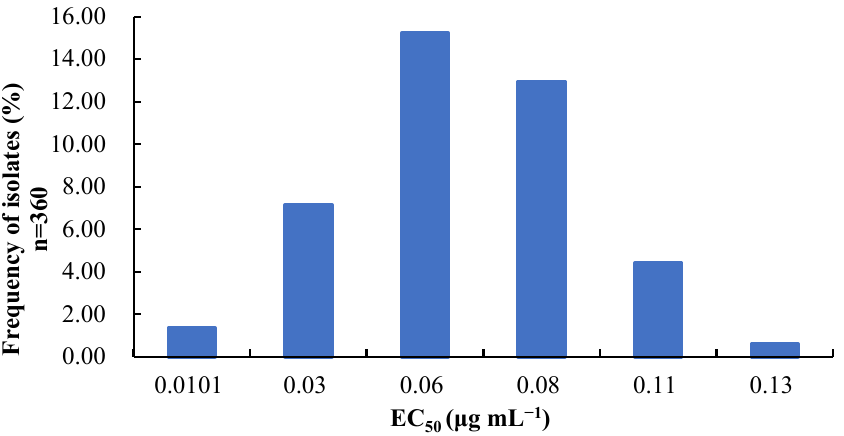
Figure 4. Frequency distribution of sensitivity of (baseline sensitivity) fluxapyroxad to R. solani .